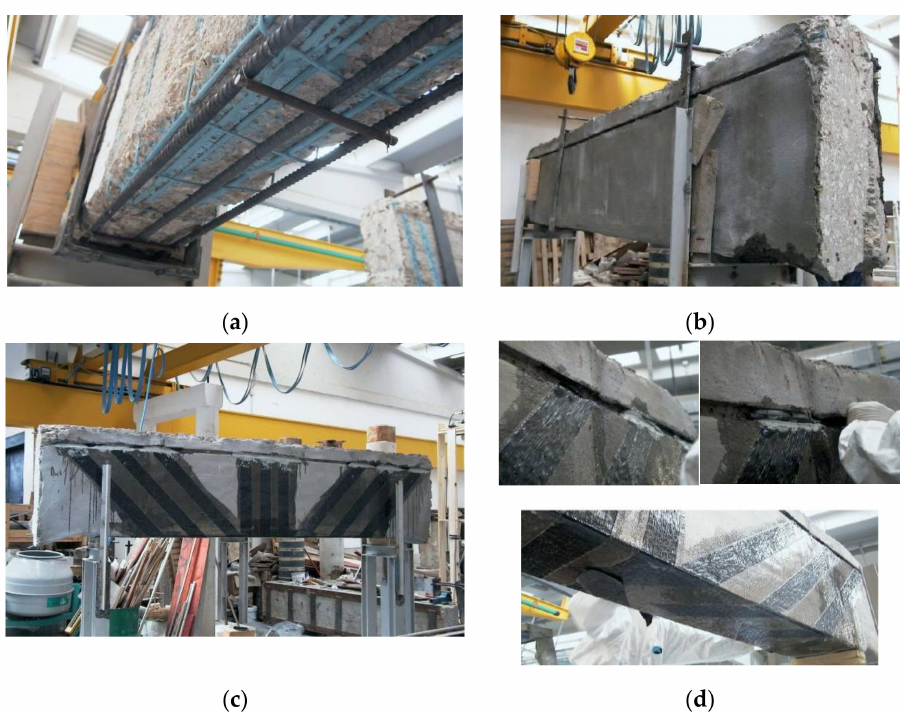
Figure 4. Beam retrofitting: ( a ) rebars cleaning and protection, addition of new bottom rebars for beam flexural strengthening; ( b ) concrete cover restoration; ( c ) CFRP U-jacketing application for beam shear strengthening; ( d ) Details of U-jacketing anchorage by pultruded composite